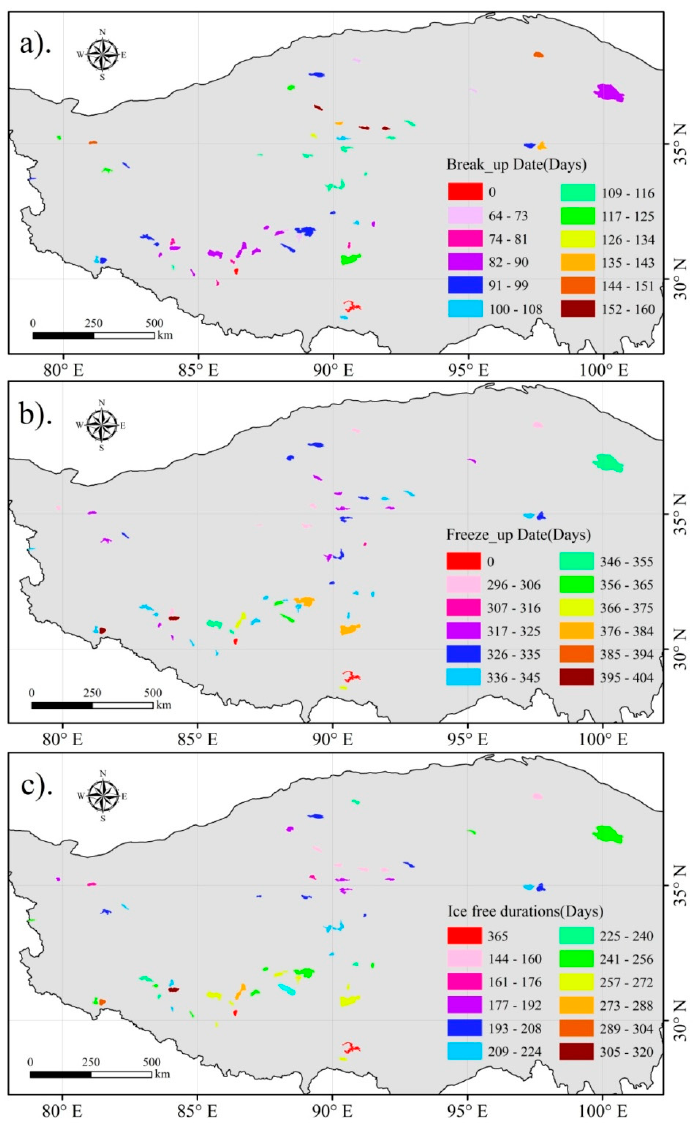
Figure 8. The timing variations of ( a ) ice break-up date, ( b ) freeze-up date and ( c ) ice-free durations for lakes across the Tibetan Plateau.